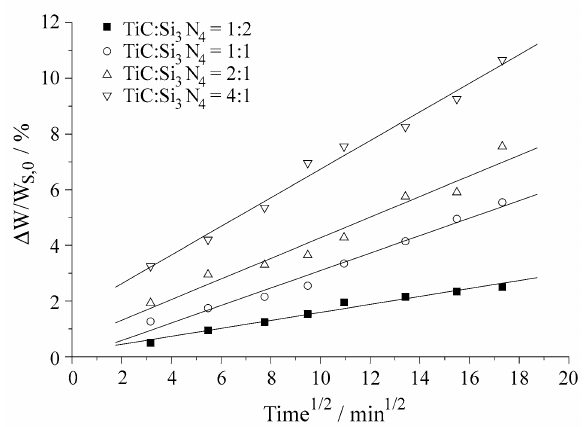
Figure 6. Same relationships as in Fig. 4 presented in parabolic coordi-